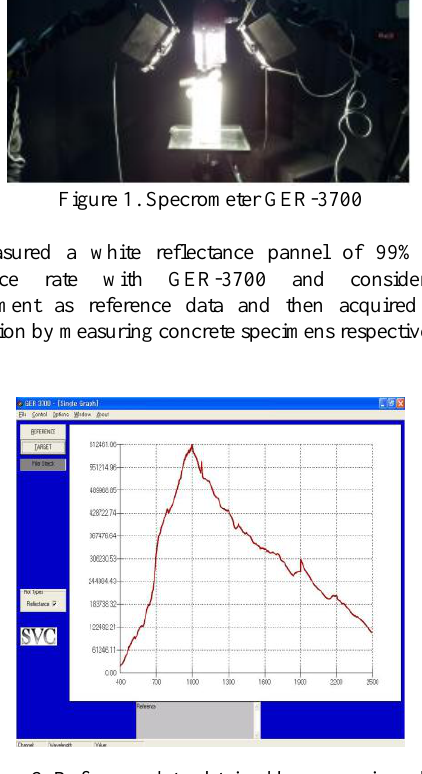
Figure 2. Reference data obtained by measuring white